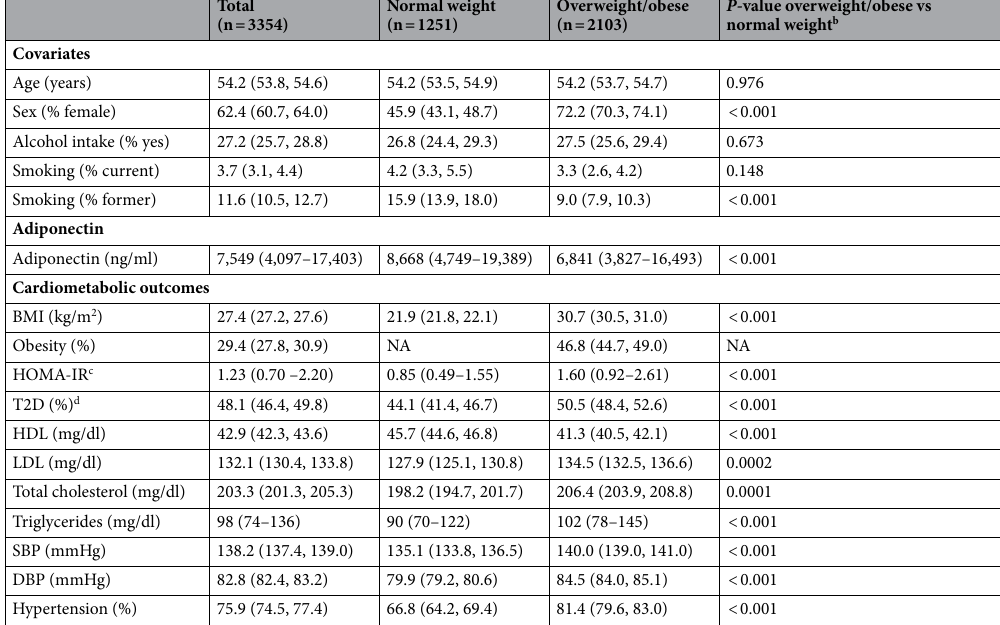
(Table 2). Effect sizes were similar for the partial and fully adjusted models for all outcomes except SBP and DBP, which had larger effect sizes in the fully adjusted model. The addition of BMI as a covariate was responsible for most of this difference in effect sizes. One SD higher adiponectin levels were associated with lower HOMA-IR (β = -0.086), triglycerides (β = -0.141), and odds for T2D (OR = 0.81). In contrast, one SD higher adiponectin levels were associated with higher HDL (β = 0.162), LDL (β = 0.047), total cholesterol (β = 0.080), SBP (β = 0.049), DBP (β = 0.054), and hypertension (OR = 1.17).